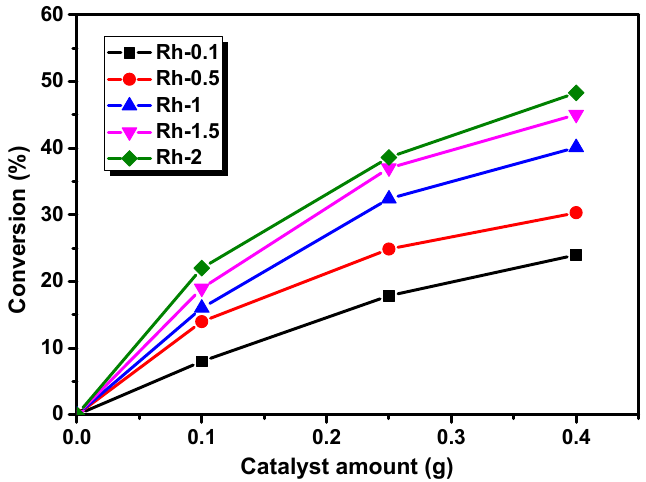
Figure 8. The cyclohexene conversion % as a function of the catalyst amount for 1 s reaction.